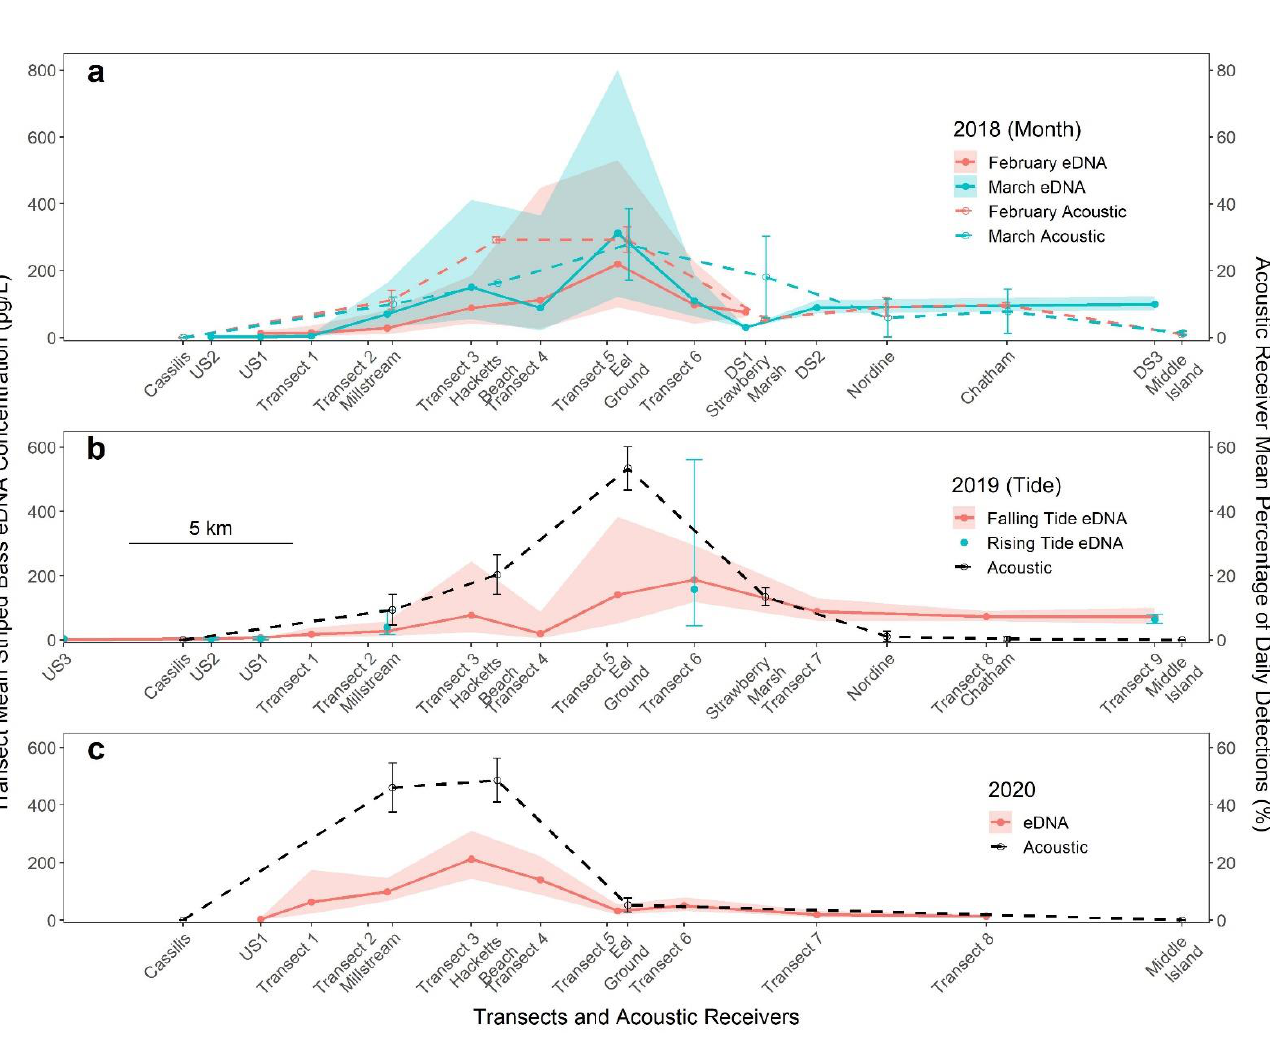
Figure 3. Back-transformed transect mean striped bass eDNA concentrations (pg/L) ± standard deviation for surface samples collected ( a ) on a falling tide in February and March 2018, ( b ) in February 2019 on falling and rising tides and ( c ) in February 2020 on a falling tide. Transect 6 in 2020 is represented by the 14:00 samples from the tidal time series; 2020 transect 5 consists of nine sampling holes. Dashed lines and hollow points are mean percentage of daily detections ± standard deviation for each acoustic receiver during the sampling periods (right axis). Distances along the x axis is to scale.